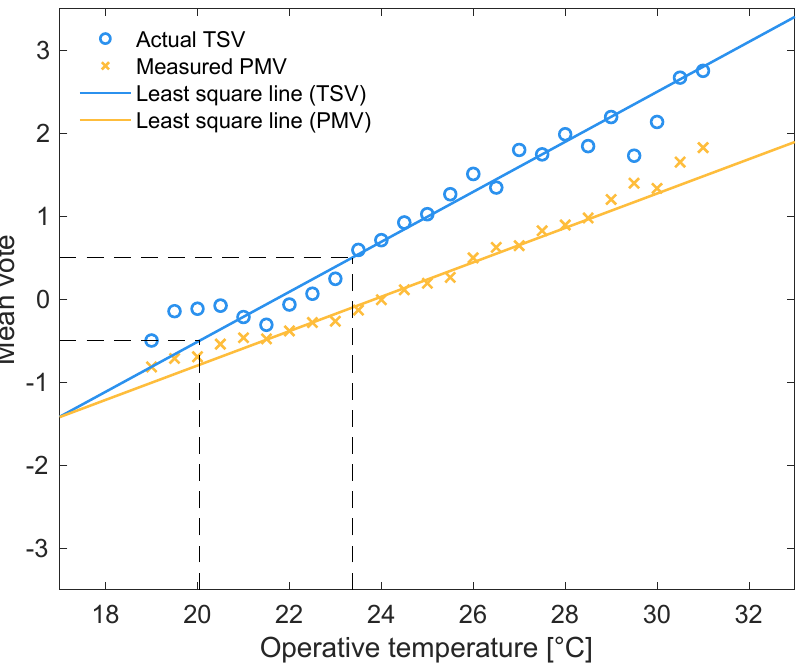
Figure 1. OT − TSV and OT − PMV relationships. The mean TSV and mean PMV are plotted against OTs binned in 0.5 ◦ C increments. Least-squares lines are generated using weighted regression to account for the number of votes in each OT bin.